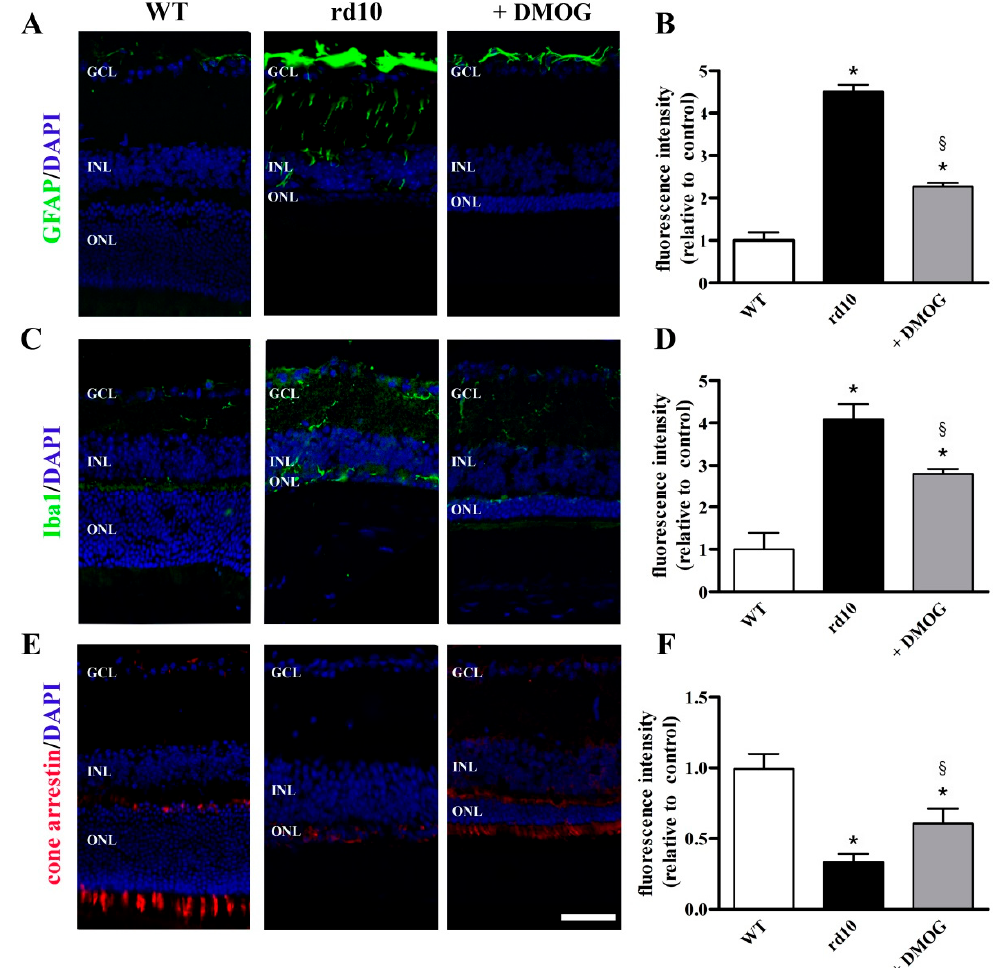
Figure 8. Localization of GFAP, Iba1 and cone arrestin in retinal sections from untreated WT and rd10 mice either untreated or treated with DMOG. ( A ) Images of retinal sections immunolabeled with antibodies against GFAP (green) and stained with DAPI (blue). ( B ) Quantitative analysis of fluorescence intensity. ( C ) Images of retinal sections immunolabeled with antibodies against Iba1 (green) and stained with DAPI (blue). ( D ) Quantitative analysis of fluorescence intensity. ( E ) Images of retinal sections immunolabeled with antibodies against cone arrestin (red) and stained with DAPI (blue). ( F ) Quantitative analysis of fluorescence intensity. In rd10 mice, DMOG decreased both GFAP and Iba1 levels, while increased cone arrestin levels. GCL, ganglion cell layer; INL, inner nuclear layer; ONL, outer nuclear layer. Scale bar, 50 µm ( n = 5 retinas per group). * p < 0.001 versus WT; § p < 0.01 versus untreated rd10 (one-way ANOVA followed by the Tukey post-hoc test).